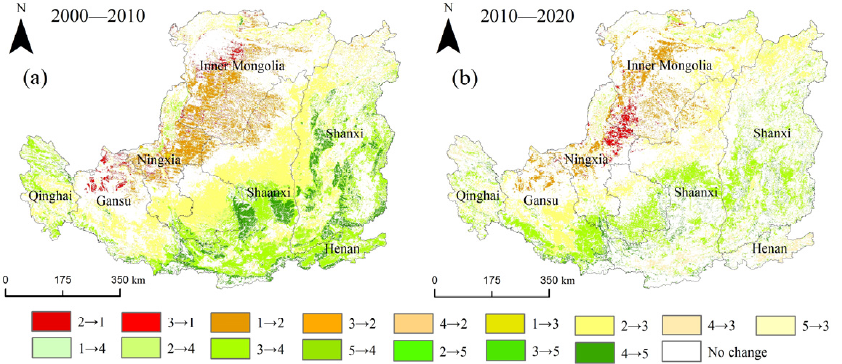
Figure 6. Spatial changes of RSEI in the Loess Plateau from ( a ) 2000–2010 and ( b ) 2010–2020. Note: